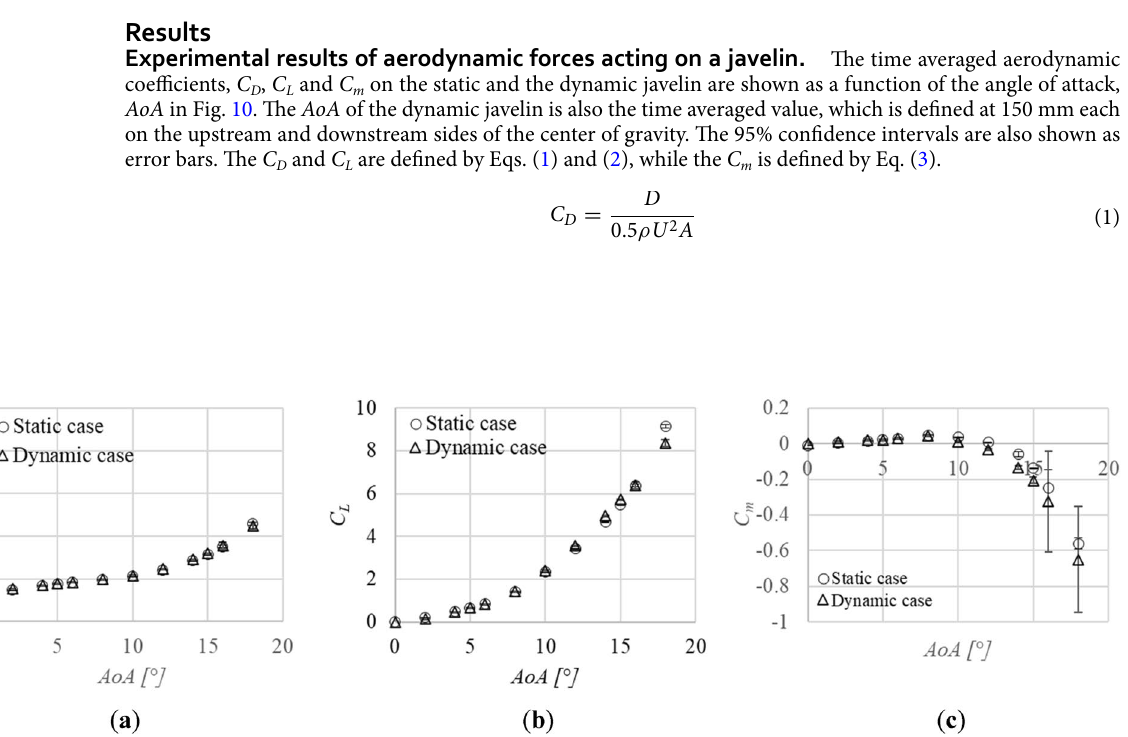
Figure 10. Aerodynamic coefficients as a function of the angle of attack, AoA . The static data are shown by open circles, while the dynamic (vibration) data are shown by open triangles. The 95% confidence intervals are also shown as error bars: ( a ) Drag coefficient, C D ; ( b ) Drag coefficient, C L ; ( c ) Pitching moment coefficient, C m